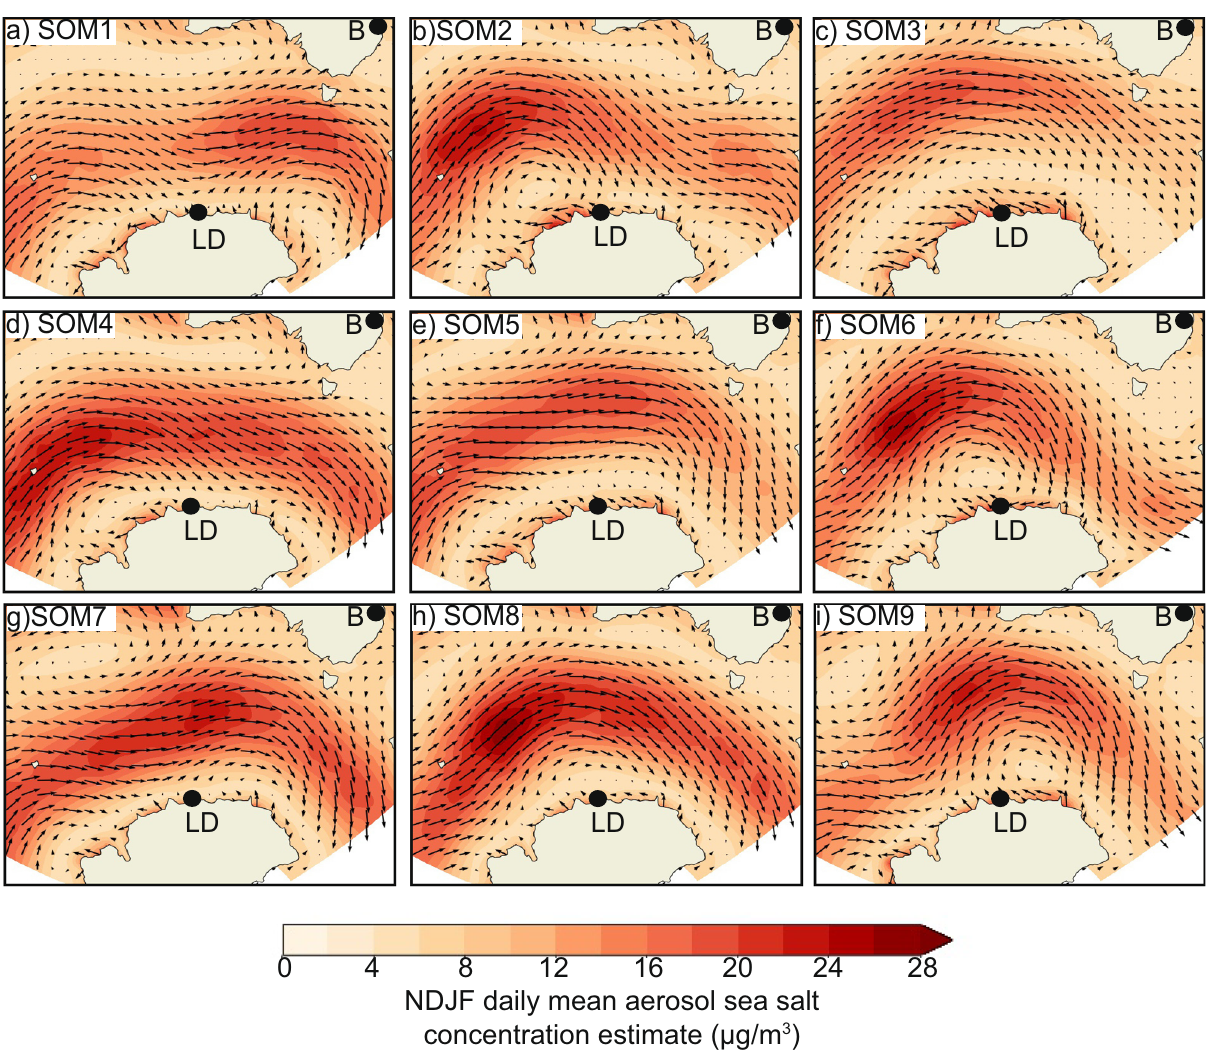
Fig. 5 NDJF estimated daily mean sea-salt aerosol generation* and mean surface (10 m) wind conditions (data: ERA-Interim 58 ) for each SOM node from ref. 33 . SOM nodes 1 to 9 are labelled ( a – i ). B = Brisbane, LD = Law Dome. *Sea-salt aerosol generation is estimated at each grid point using the ref. 64 equation, which relates sea-salt aerosol generation to local surface wind